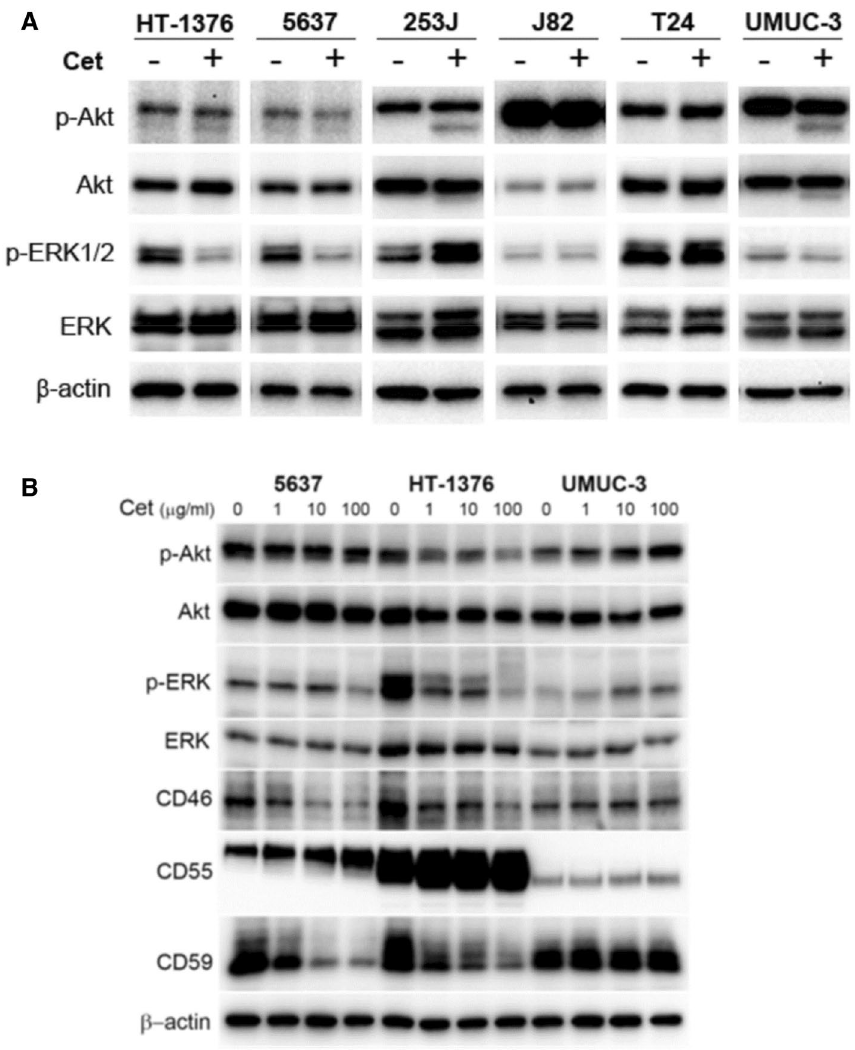
Figure 2. Effects of cetuximab on EGFR-dependent intracellular signaling in human bladder cancer cell lines. Corresponding cells were treated with cetuximab at a final concentration of 100 μg/ml ( A ) or 1–100 μg/ml ( B ). After 36 h, total cell protein extracts were subjected to immunoblotting with the indicated antibodies, as described in “Materials and methods”. Experiments were repeated three times with similar